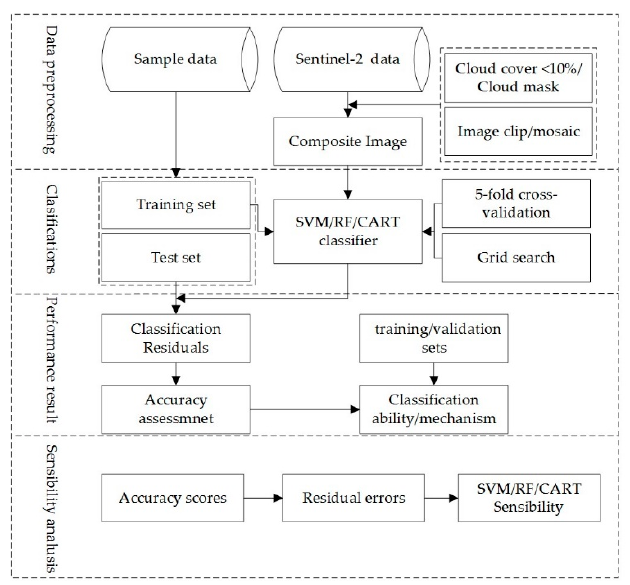
Figure 3. Overall workflow of this study.